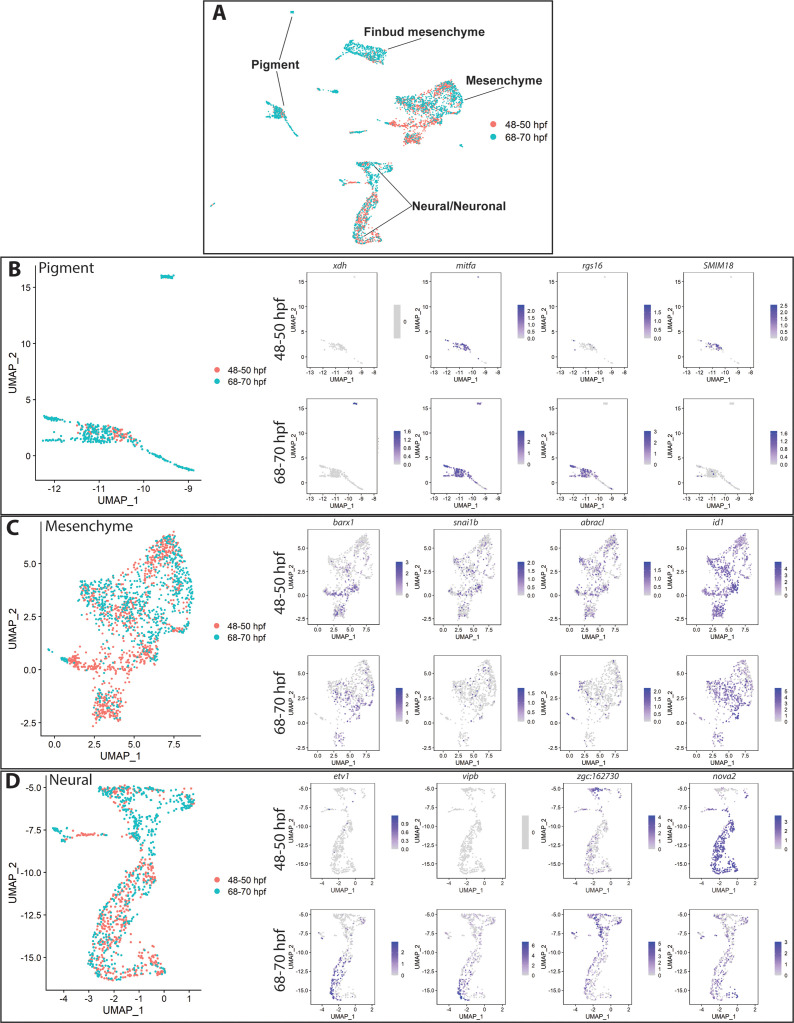
Differential expression among pigment, mesenchyme and neural/neuronal subsets of the sox10:GFP+ atlas (A) UMAP visualization of cells labeled by source identity (either 48–50 hpf or 68–70 hpf) following integration.All 48–50 hpf cells (pink) approximately map to a major cluster found at 68–70 hpf (aqua). (B–D) Subset of the pigment clusters (B), the mesenchyme clusters (C), and the neural/neuronal clusters (D) highlighting several differentially expressed genes between the cells derived from each timepoint.